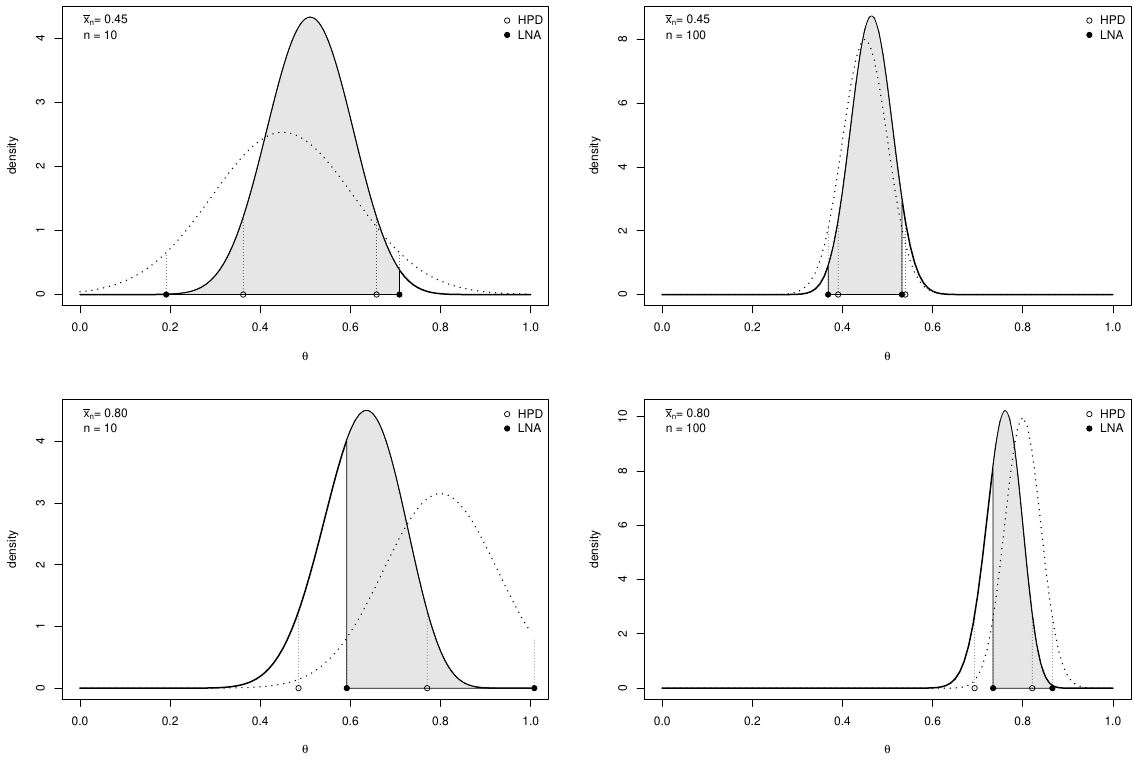
Figure 1. Posterior density, given a prior density of hyperparameters ( α , β ) = ( 10.8,9.2 ) , and likelihood approximation, given ¯ x n = 0.45 ( top row ) and ¯ x n = 0.8 ( bottom row ) for n = 10 ( left column ) and n = 100 ( right column ). Exact credible intervals (HPD: Highest Posterior Density) are denoted by empty circles, likelihood approximated credible intervals (LNA: Likelihood Normal Approximation) are denoted by black circles. The probability that θ belongs to the approximate interval under the exact posterior distribution is highlighted in